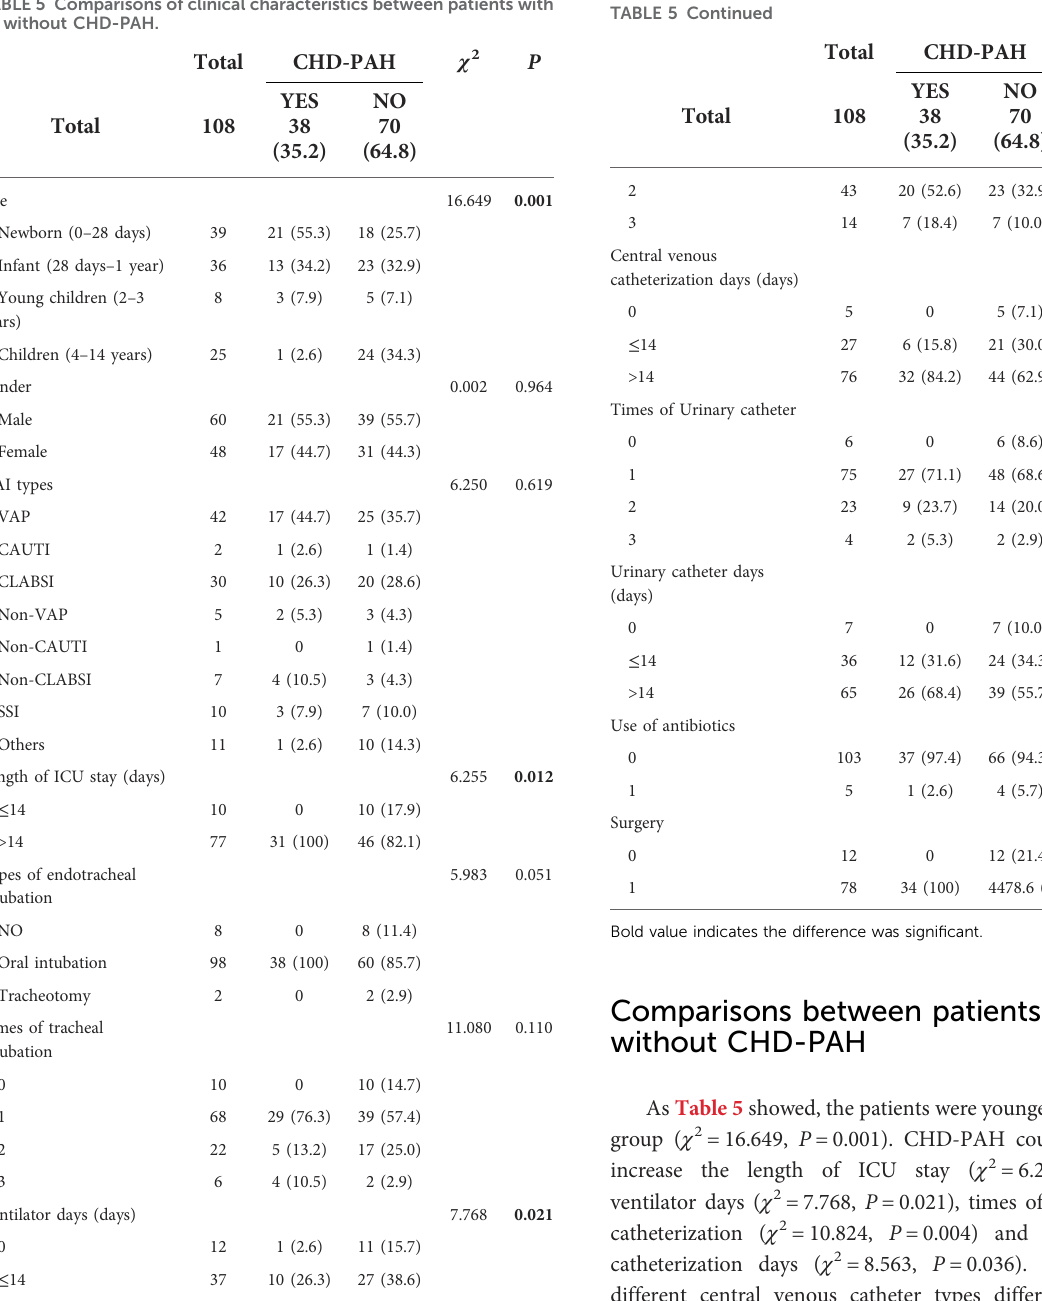
TABLE 5 Comparisons of clinical characteristics between patients with or without CHD-PAH.